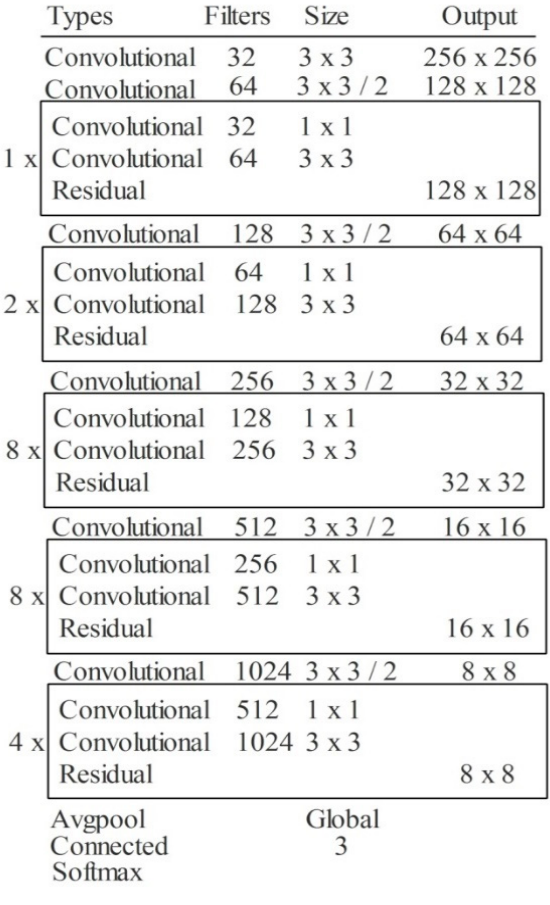
Figure 4. The layer wise architecture of Modified DarkNet-53 deep model.